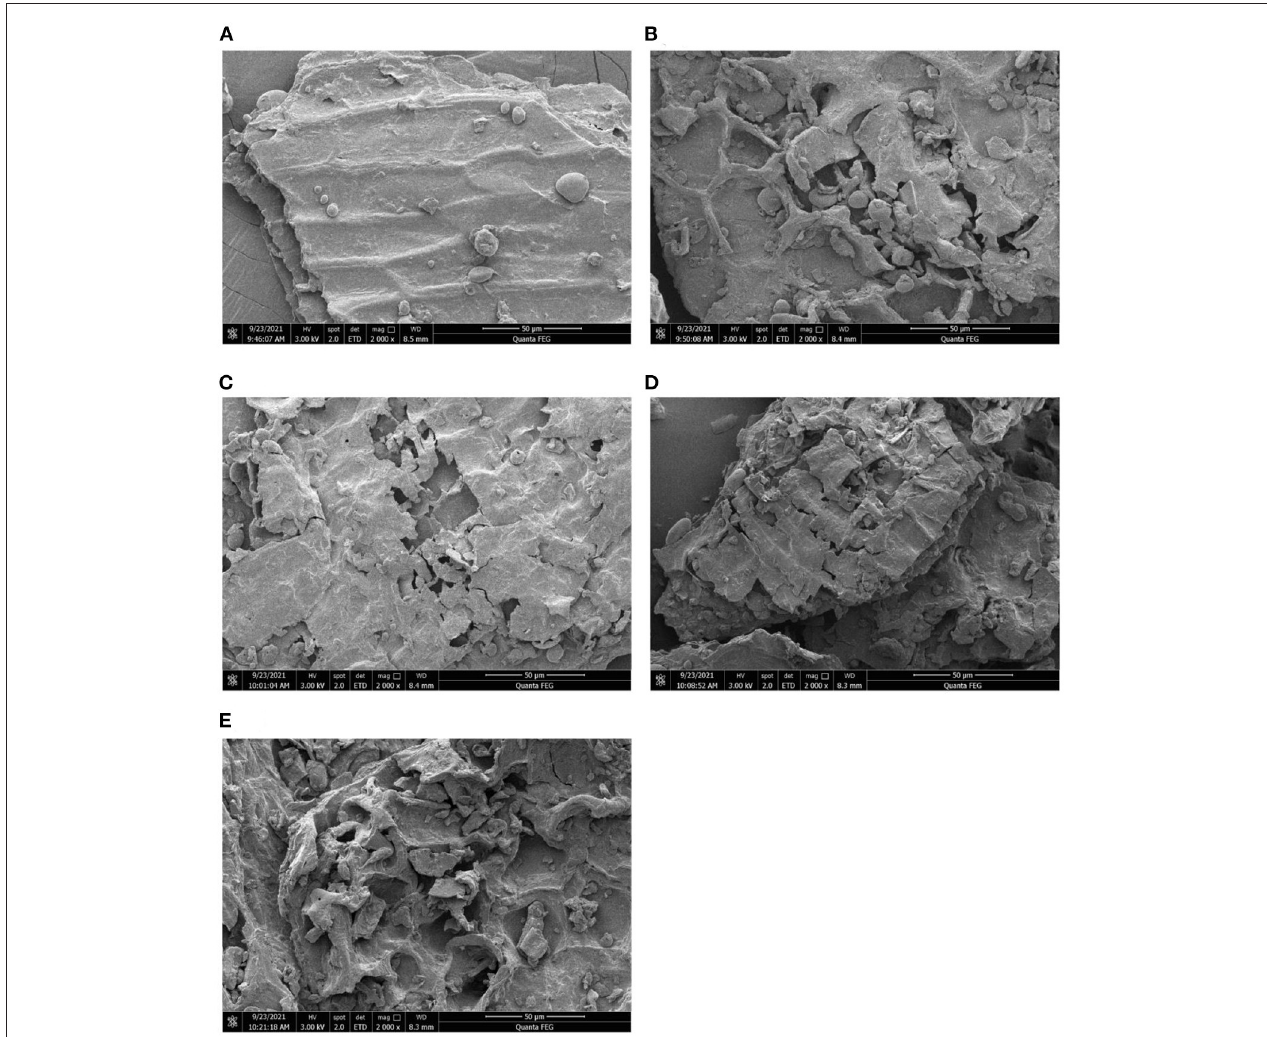
FIGURE 2 | Scanning electron microscopy (SEM) image of W-IDF. (A) C-IDF, (B) P-IDF, (C) A-IDF, (D) B-IDF, (E) M-IDF.